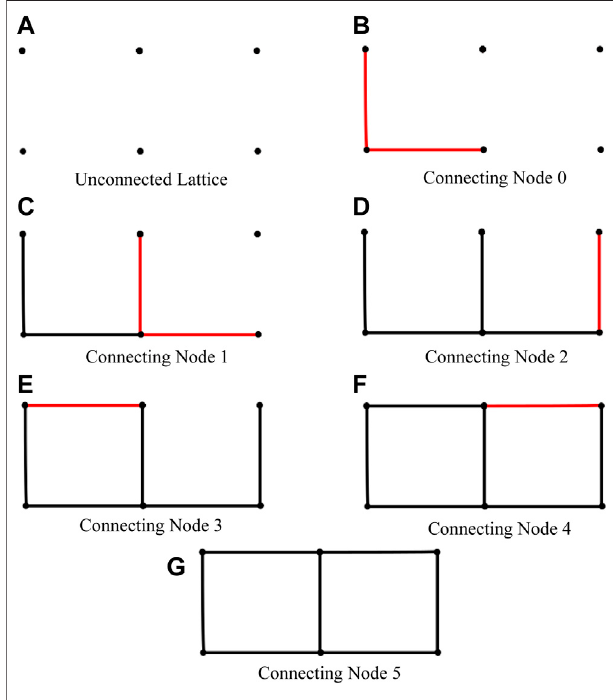
FIGURE 8 | Formation of 2 × 3 square lattice. (A) Unconnected lattice. (B) Connecting node 0. (C) Connecting node 1. (D) Connecting node 2. (E) Connecting node 3. (F) Connecting node 4. (G) Connecting node